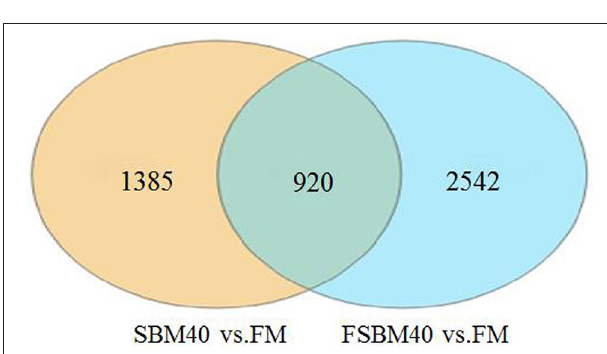
FIGURE 3 | Venn map analysis of significant differential gene between soybean meal and fermented soybean meal in hindgut of pearl gentian grouper ( n = 4).